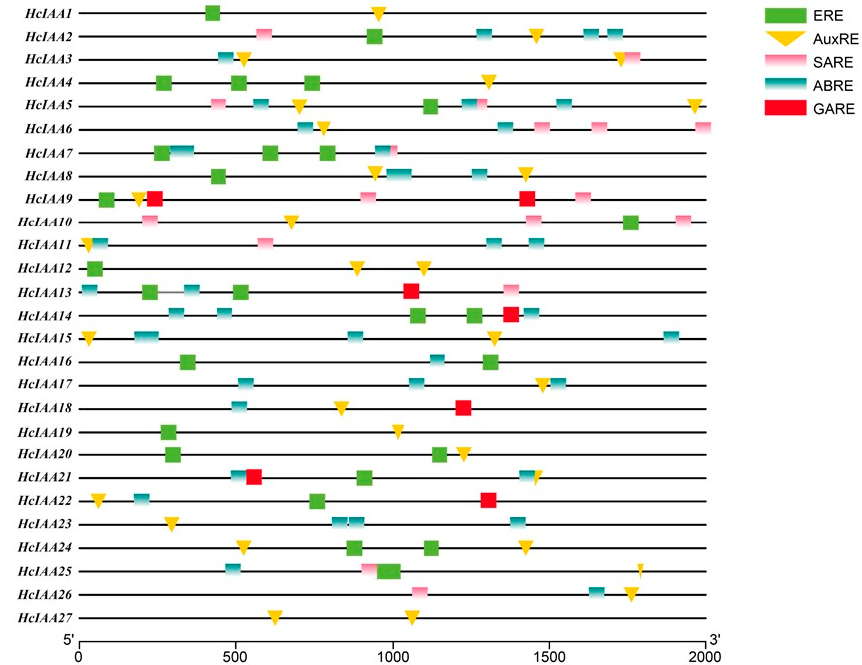
Figure 4. Analysis of specific cis -elements in promoters. The 2000 bp promoter sequences of HcIAA genes were used to analyze specific hormone-related cis -elements, including AuxRE, SARE, GARE, ERE and ABRE, which are color-coded. The AuxRE element is indicated with an inverted triangle.